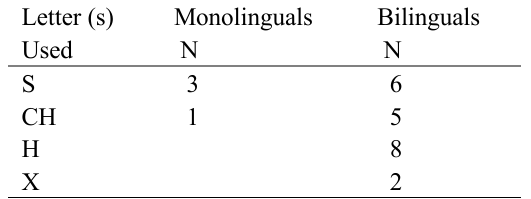
Table 11. Misspellings for the phoneme / ʃ / in shoe Letter (s)